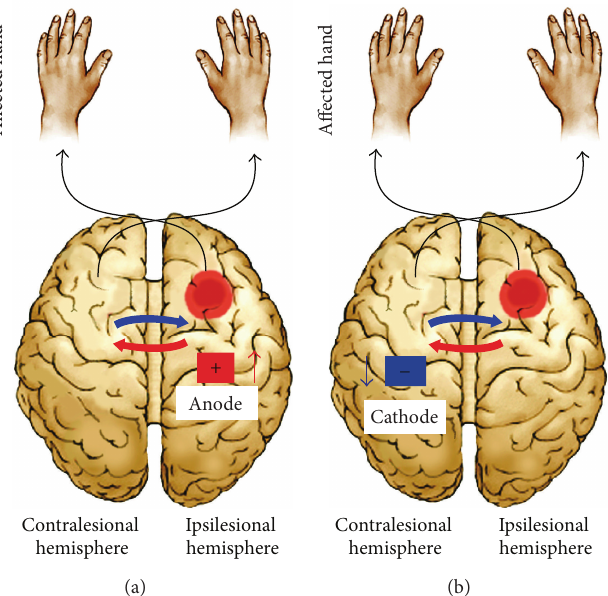
Figure 2: Interhemispheric competition following a stroke. The model suggests that the contralesional (unaffected) motor region exerts an excessive inhibitory influence on the ipsilesional (affected) motor cortex which might limit poststroke motor recovery. The model provides a hypothetical framework for developing therapeutic strategies. (a) Upregulation of neural excitability of the intact regions of the ipsilesional (affected) motor cortex by anodal tDCS. (b) Downregulation of excitability of the contralesional (unaffected) motor cortex by cathodal